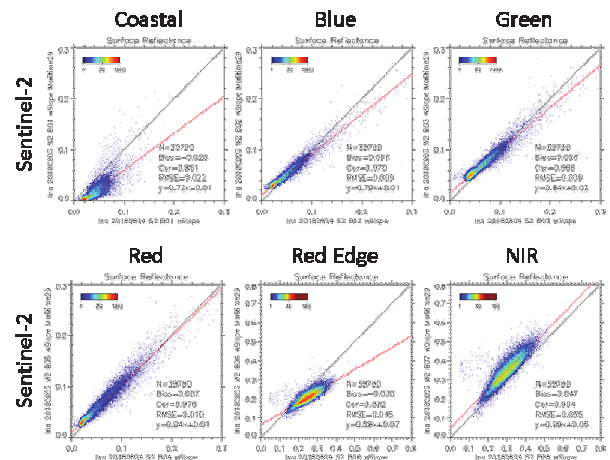
Figure 8. Comparison the surface reflectance between the derived from WorldView-2 and